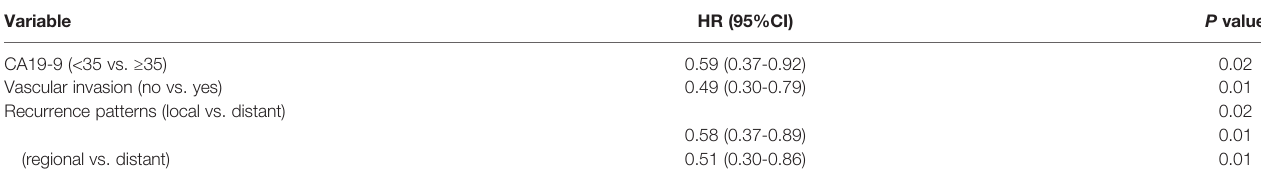
TABLE 4 | Multivariate analysis of overall survival after radical cholangiocarcinoma surgery. Variable CA19-9 (<35 vs. ≥